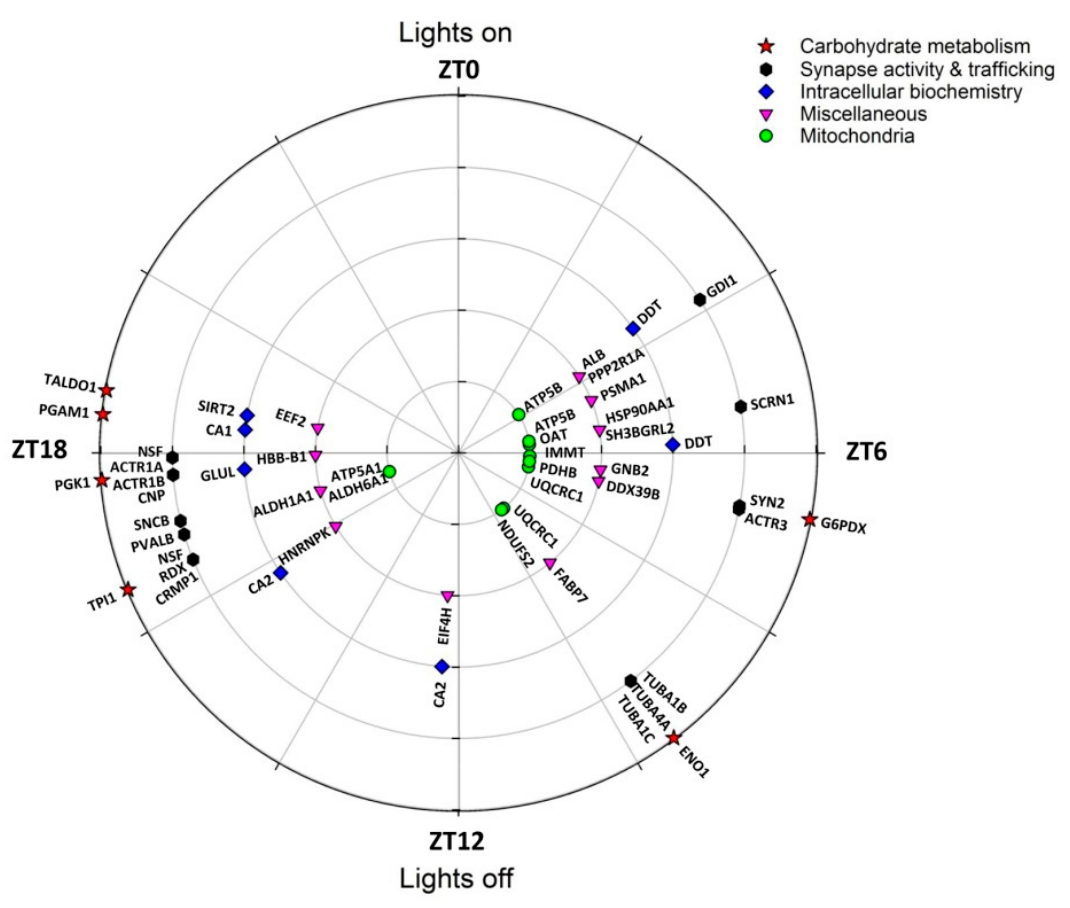
Figure 2. Polar plot showing the temporal distribution of peak phase of rhythmic proteins in the mouse cerebellum according to their function.